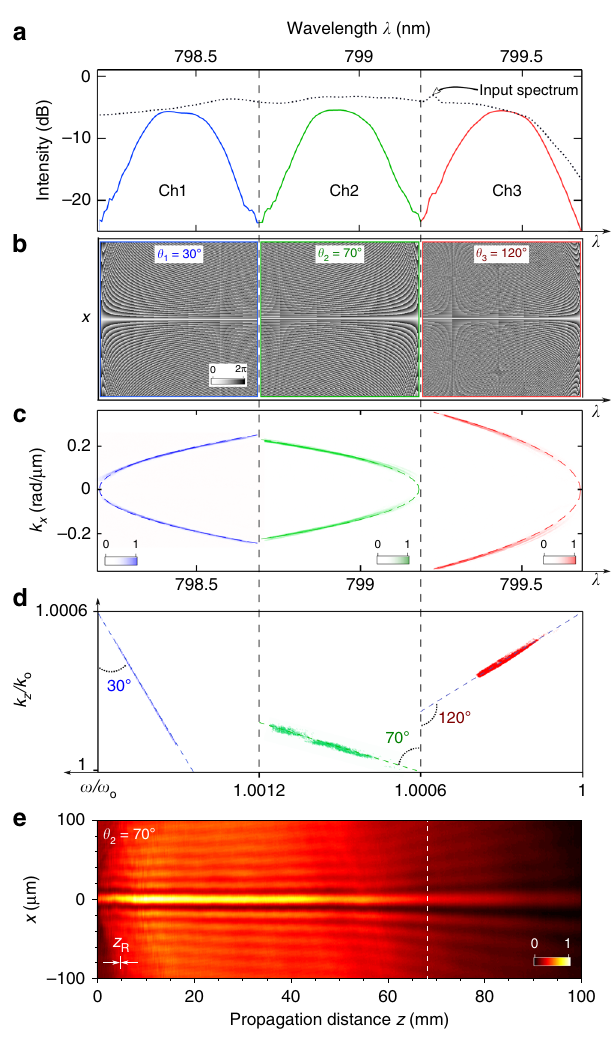
Fig. 2 Assigning different group velocities to ST wave packets in distinct spectral channels. a Spectra of the three spectral channels (solid curves) alongside the spectrum of the Ti:sapphire laser (dotted curve). b The 2D SLM phase distributions across the three channels to synthesize different ST wave packets: subluminal, Ch1; superluminal, Ch2; and negative- e v , Ch3. c Measured spatio-temporal spectrum j e E ð k x ; λ Þj 2 of the co-synthesized ST wave packets in the three spectral channels. Dashed curves are the theoretical expectations. d Spatio-temporal spectral projections onto the ð k ; ω Þ -plane. The spectra for the different channels are shifted along the k z c axis to fall within the same range for clarity. e Measured time-averaged axial evolution of the intensity I ( x , z ) = ∫ dt ∣ E ( x , z , t ) ∣ 2 of Ch2. Note the difference in scale along x and z . The thin white bar in the bottom-left corner corresponds to the Rayleigh range z R of a Gaussian beam having the same width as the ST wave packet. The vertical dashed line identi fi es z ¼ L max